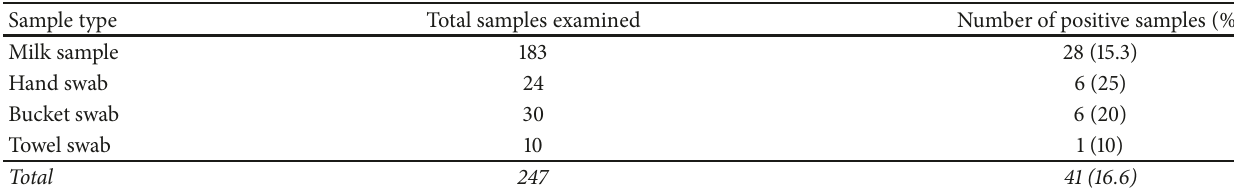
Table 4: Percentage of Staphylococcus aureus isolate from raw milk and swab